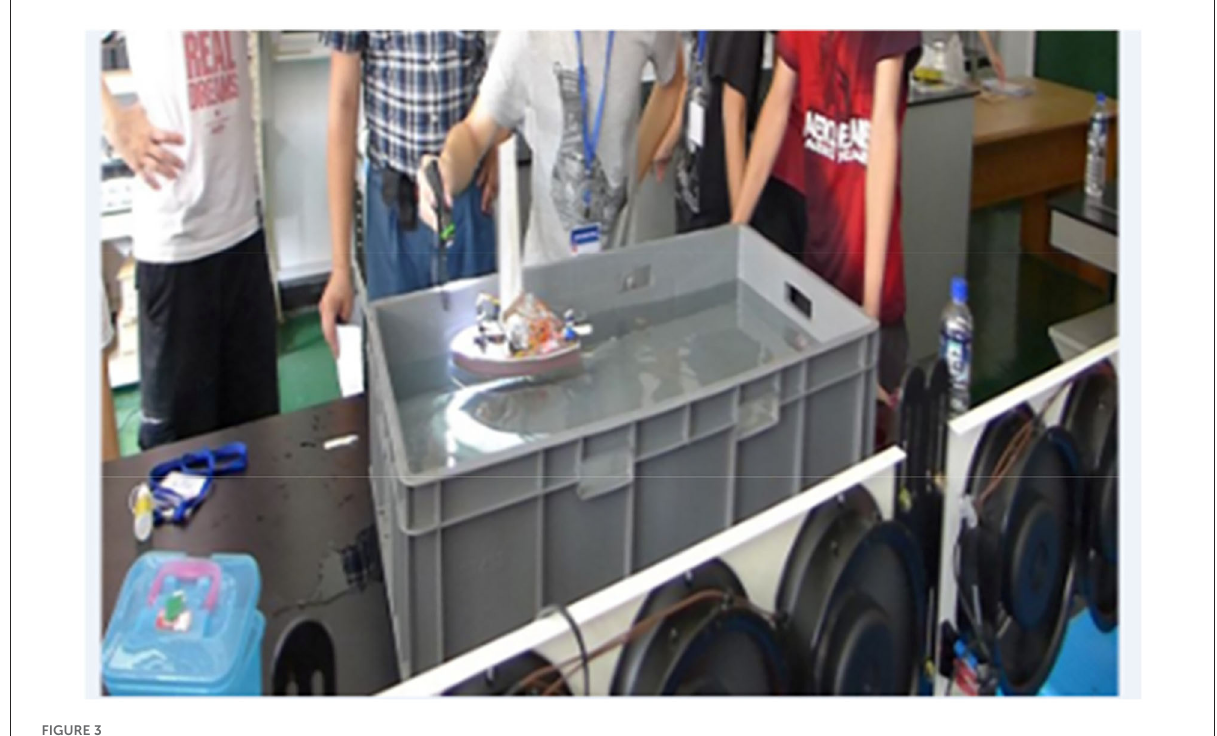
FIGURE3 Sharing works—group